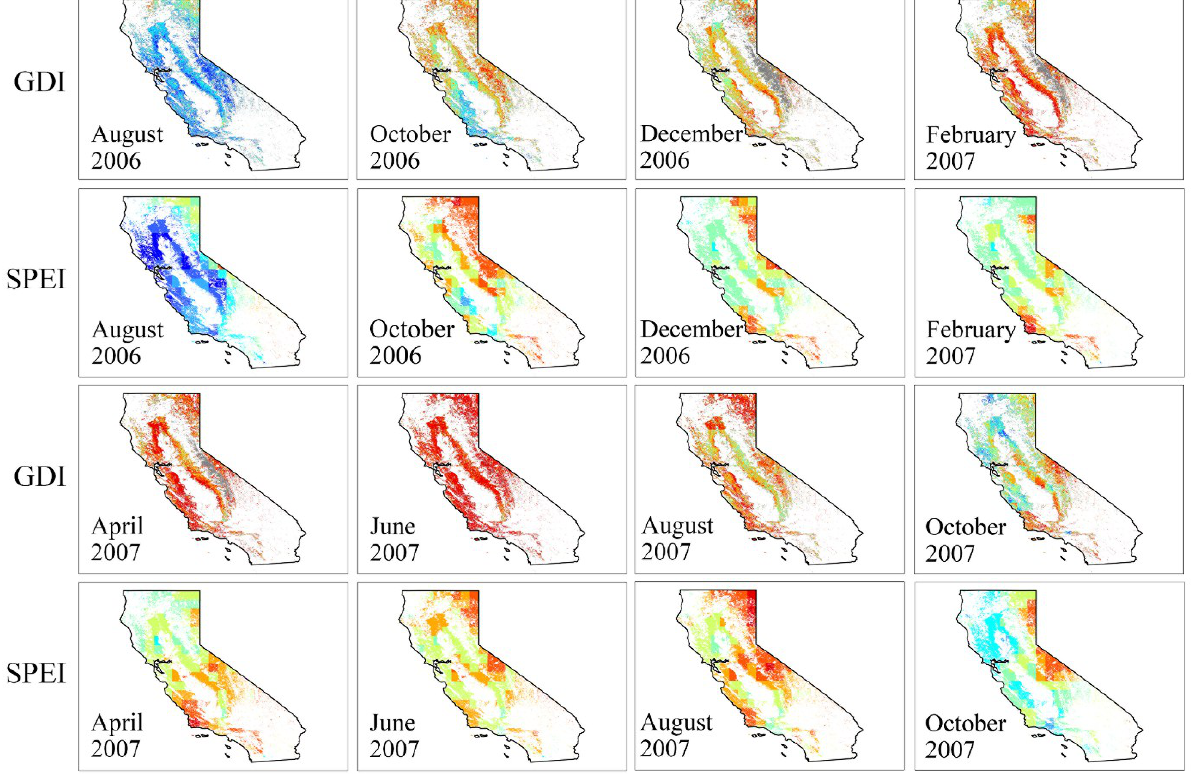
Figure 12. The performance of the GDI-6CRU and SPEI-6mon in grassland